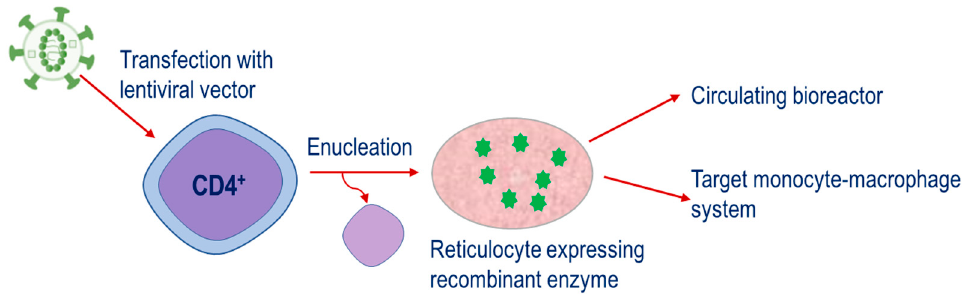
Figure 4. Strategy for therapeutic enzymes produced through the transfection of CD34 + cells with lentiviral vectors containing constructs encoding for the enzyme of interest. Cells are expanded and differentiated until the nucleus is ejected, resulting in the mature reticulocyte expressing the recombinant enzyme.